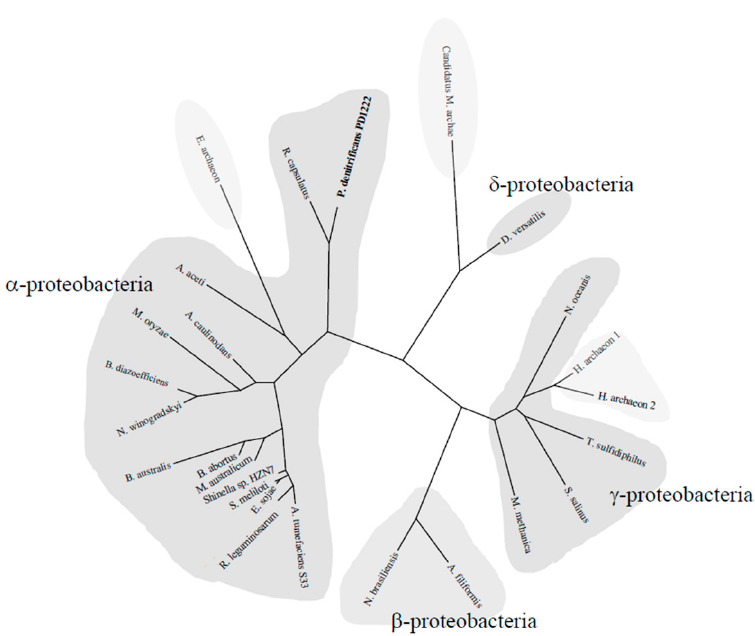
Figure 5. Phylogenetic tree of the NtrYX system in proteobacteria and archaea. The tree was con- structed using the Phylogeny.fr platform [24]. Sequences were aligned with MUSCLE v3.8.31 with default settings. Ambiguous regions were removed with Gblocks (v0.91b). The phylogenetic tree was reconstructed using the maximum likelihood method implemented in the PhyML program (3.1/3.0 aLRT). Graphical representation and edition of the phylogenetic tree were performed with TreeDyn (v198.3). The P. denitrificans NtrY sequence is highlighted in bold. Protein sequences cor- respond to the following organisms and accession numbers: Paracoccus denitrificans PD1222 (A1B9J8), Acetobacter aceti (A0A1U9KGH8), Agrobacterium tumefaciens S33 (AMD59098), Bartonella australis (M1NY36), Bradyrhizobium diazoefficiens USDA 110 (Q89LQ4), Brucella abortus S19 (A0A0F6AQY7), Rhizobium leguminosarum bv. trifolii CB782 (AHG45292), Mesorhizobium australicum (L0KR80), Methy- lobacterium oryzae (A0A089Q4X3), Sinorhizobium meliloti 1021 (Q92Q88), Ensifer sojae (A0A249PA03), Shinella sp. HZN7 (A0A1A9G8A8), Nitrobacter winogradskyi (Q3SSN4), Azorhizobium caulinodans (Q04850), Rhodobacter capsulatus (D5AUA5), Neisseria brasiliensis (A0A5Q3RYY2), Alysiella filiformis (QMT30538), Methylomonas methanica (G0A7N2), Nitrosococcus oceanis (Q3J6T6), Thioalkalivibrio sul-